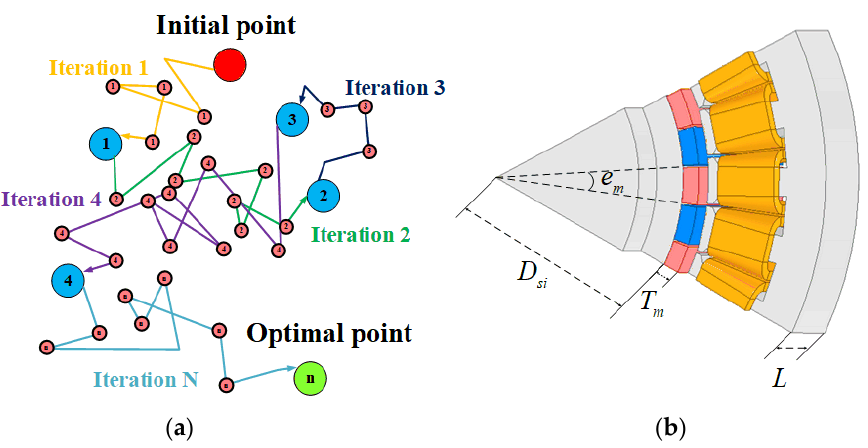
Figure 5. Design parameters used in optimization algorithm: ( a ) RWA’s global solution exploration process and ( b ) optimal design parameters of the